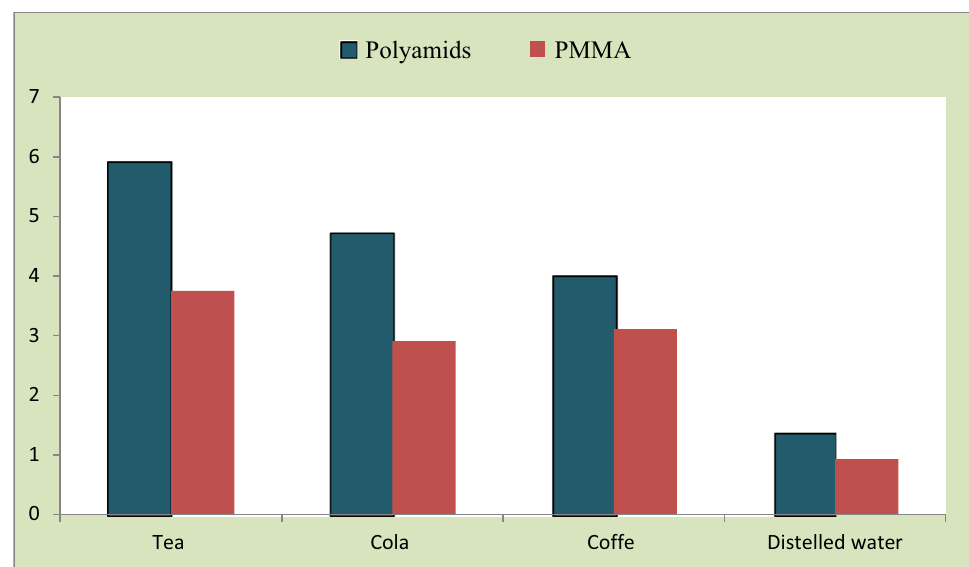
Fig. 2 ∆E Values of Specimens in Four Different Solutions for 7